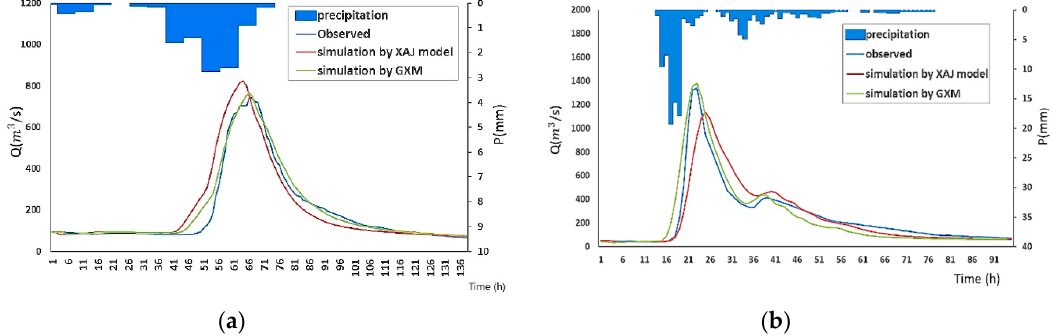
Figure 6. Examples of simulated and observed hydrographs with uniform rainfall: ( a ) 3–9 September 2003 (Chenhe Watershed); ( b ) 27 June–1 July 2002 (Changhua Watershed).